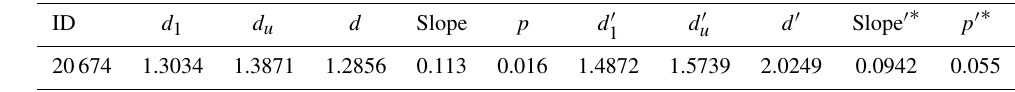
Table A2. Trends in annual mean snow depth with the Durbin–Watson test for the Dikson site during 1966–2012. ID d 1 d u d Slope p d (cid:48)